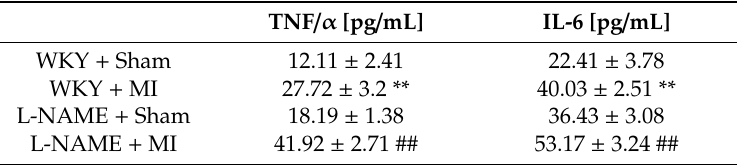
Table 3. Tumor necrosis factor α (TNF- α ) and interleukin 6 (IL-6) levels of sham operated Wistar Kyoto rats (WKY + Sham); WKY rats with experimentally induced myocardial infarction (WKY + MI); sham operated WKY rats treated with L-NAME (20 mg / kg / day) (L-NAME + Sham) and L-NAME (20 mg / kg / day) treated WKY rats with experimentally induced myocardial infarction (L-NAME + MI); ** p < 0.01 compared to WKY + Sham; ## p < 0.01 compared to L-NAME + Sham group; N = 6 in each